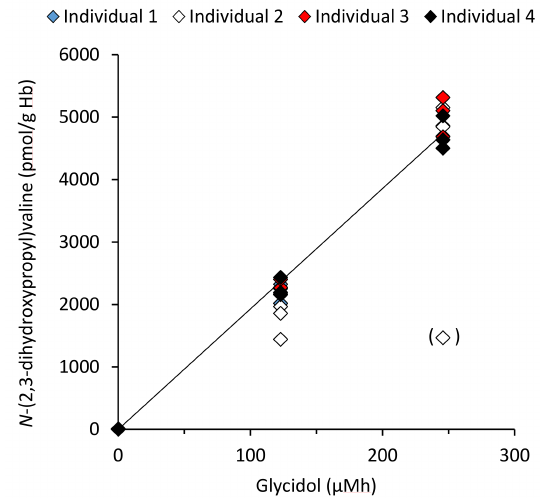
Figure 4. Determination of the second-order reaction rate constant, k val , for the formation of the N -(2,3-dihydroxypropyl)valine adduct in Hb. The data points represent the adduct levels from 1-hour incubations of glycidol with fresh human blood from triplicate samples at each dose level from four individuals, where each point corresponds to the mean from two m/z transitions. One replicate at the highest dose for individual 2 (data point in parenthesis) was excluded in the analyses as it was judged as an outlier (Grubbs